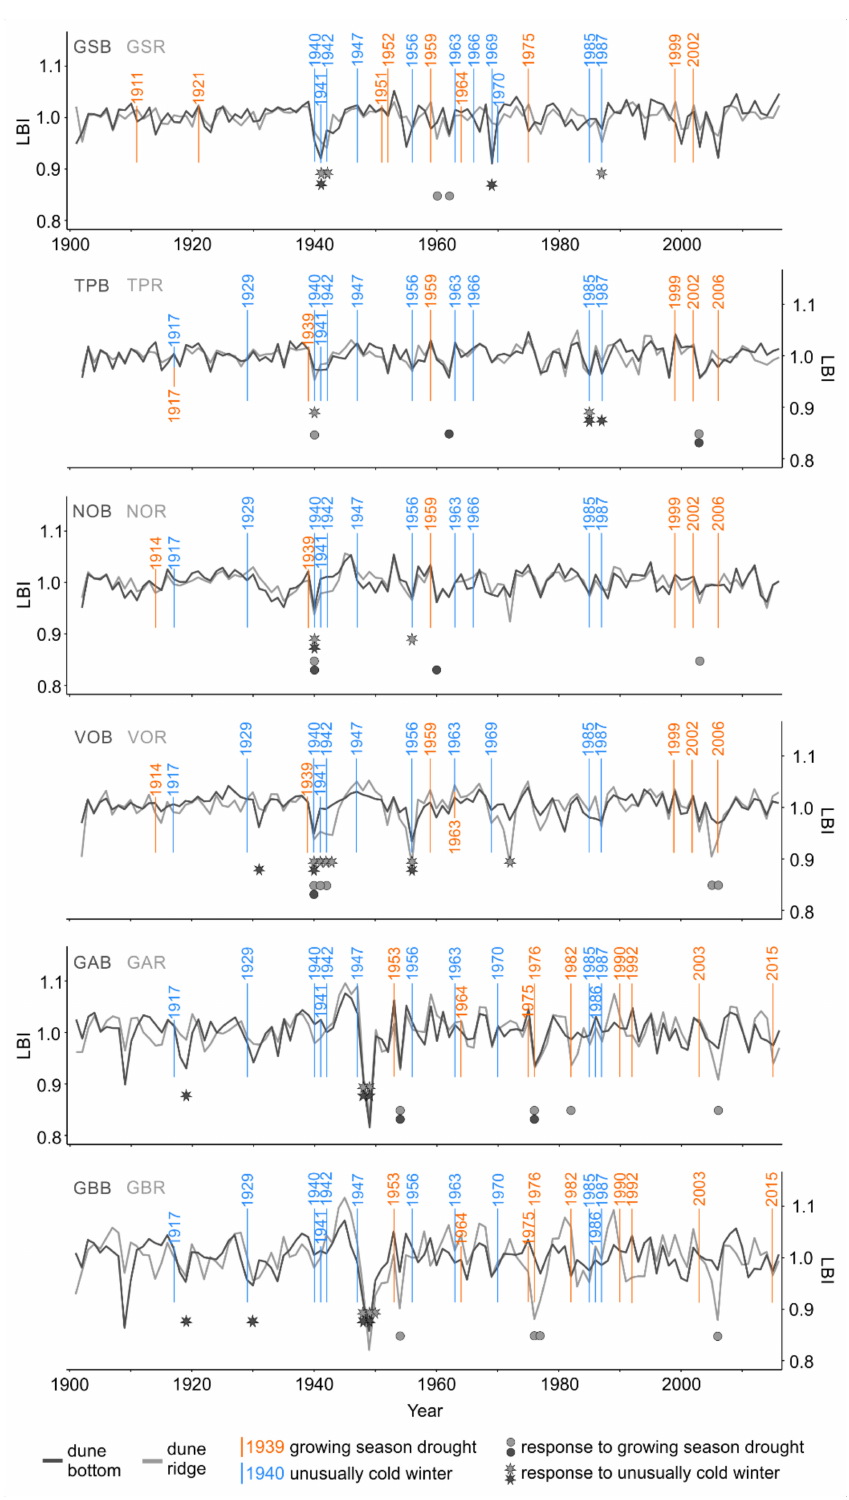
Figure 6. Standardized microsite latewood blue intensity chronologies (dune bottom = dark gray line, dune ridge = light gray line), individual site-specific droughts (orange vertical lines) and cold winters (blue vertical lines) as well as the timing of growth reductions to droughts (dune bottom = dark gray dots, dune ridge = light gray dots) and cold winters (dune bottom = dark gray stars, dune ridge = light gray stars). The occurrence and significance of growth reductions were determined by means of the superposed epoch analysis ( p < 0.05). The number of consecutive dots or stars indicates the duration of growth reduction after drought or cold winter, respectively. See Table 1 for description of microsite names and